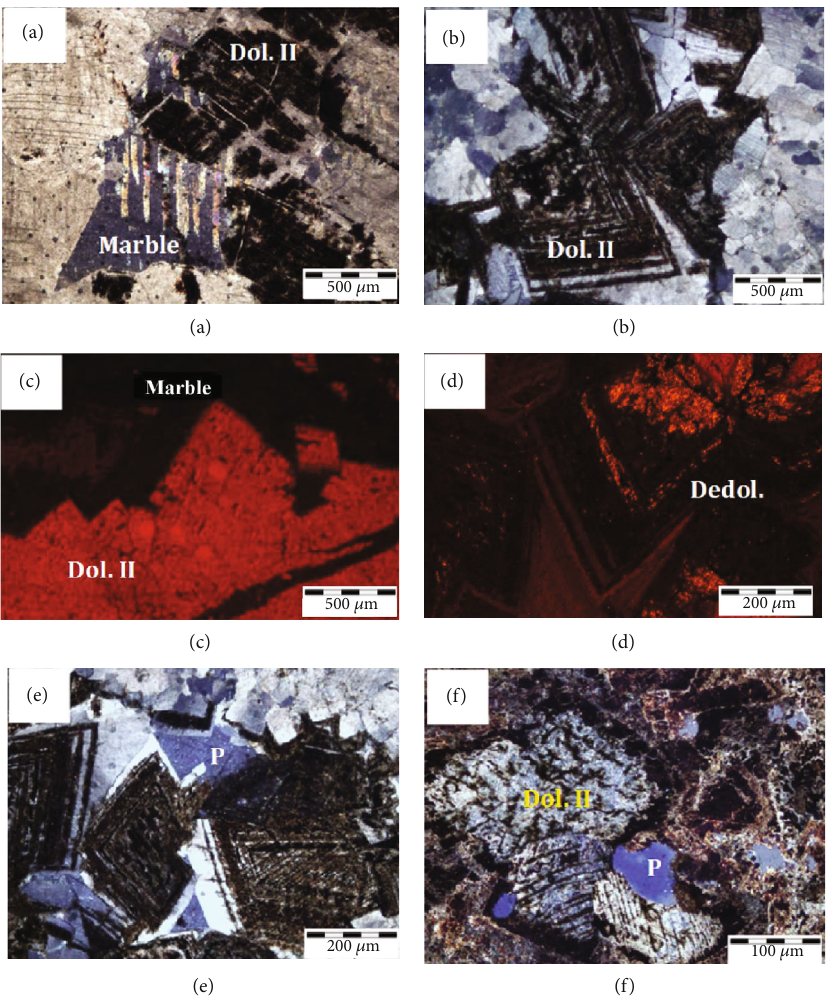
Figure 6: Petrographic studies of the Khyber Limestone showing various diagenetic phases. (a) Crossed-polarized photomicrograph showing brown color medium to coarse crystalline, dolomite in contact with marble. Note that the Dol. II postdates the marble. (b) Crossed-polarized photomicrograph showing pore- fi lling dolomite Dol. II in medium- to coarse-grained marble. (c) Cathodoluminescence photomicrograph showing bright red luminescence of dolomite (Dol. II), and marble with dull orange luminescence. (d) Cathodoluminescence photomicrograph showing progressive dedolomitisation is indicated by the change from bright red luminescent dolomite (Dol. II) to dull orange-colored calcite. (e) Crossed-polarized photomicrograph showing intercrystalline porosity (P) in the Dol. II. The crystals of Dol. II are in contact with medium- to coarse-grained marble. (f) Cross-polarized photomicrograph showing calcitization and dissolution porosity (P) in Dol.